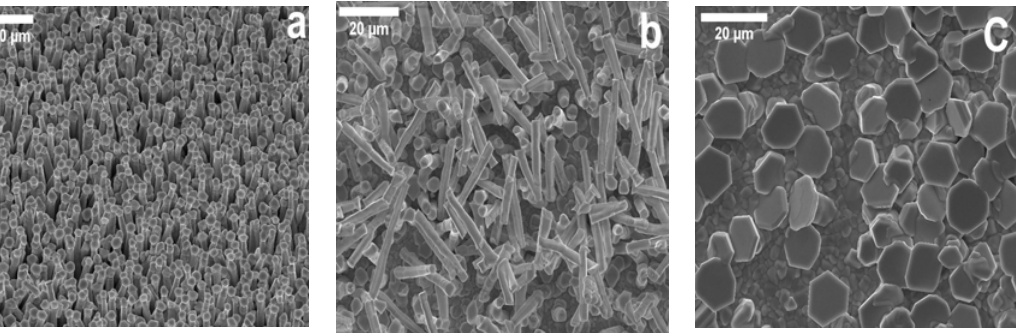
Figure 2. SEM images of CdTe wire growth with varying deposition pressure. ( a ) Vacuum; ( b ) 30 Torr and ( c ) 60 Torr.